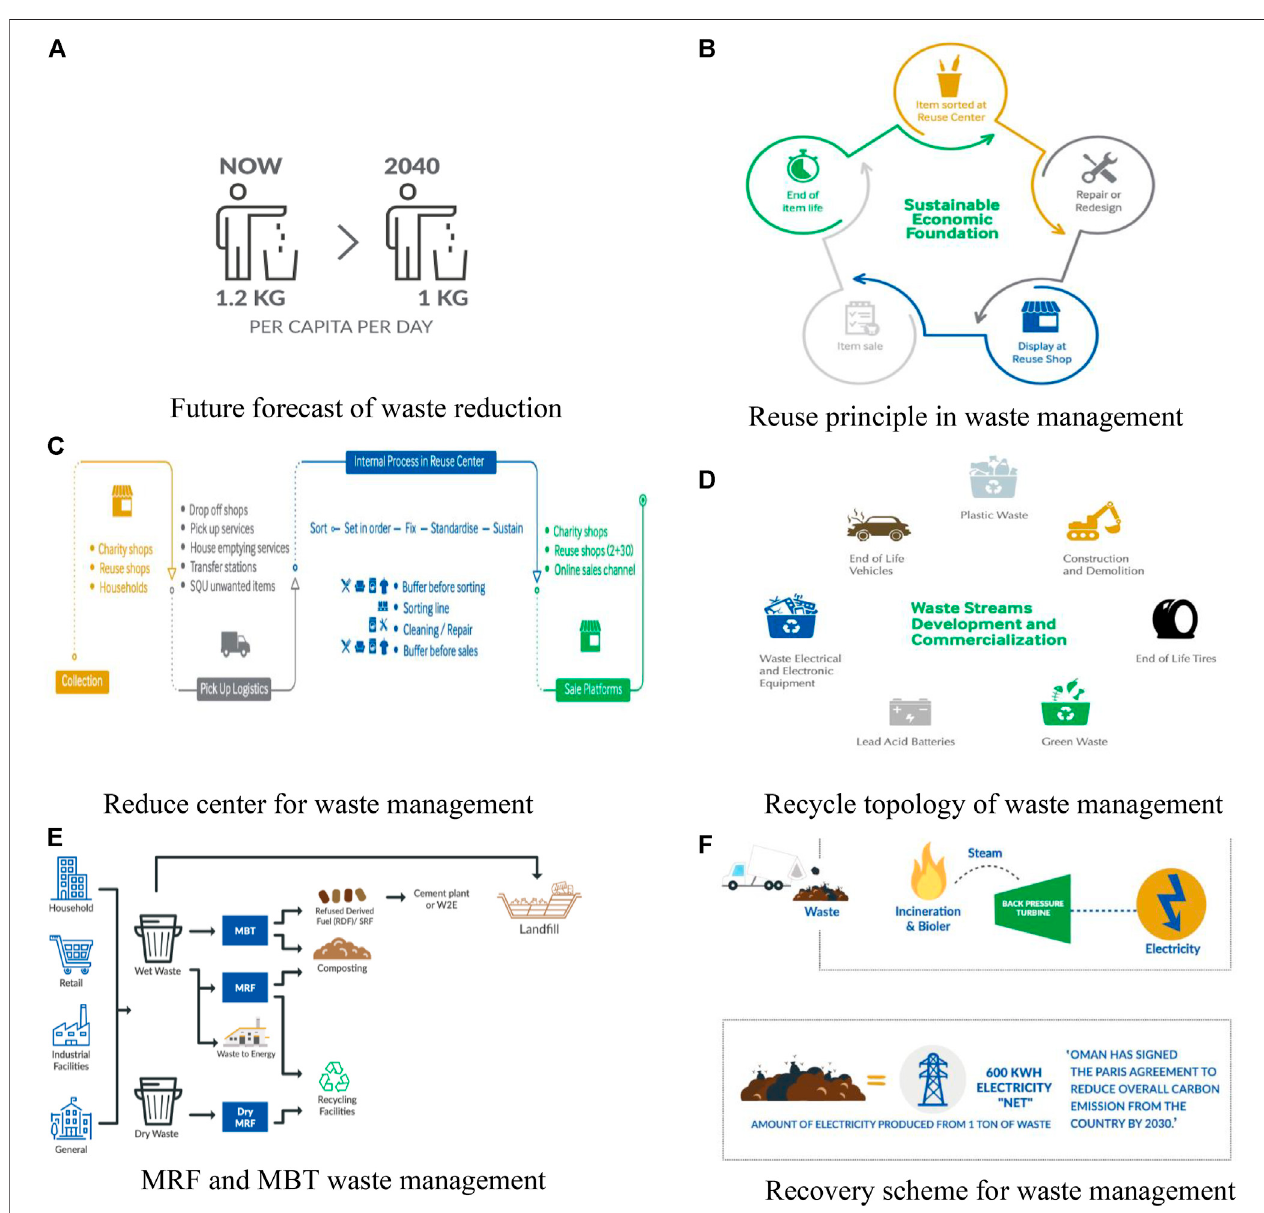
FIGURE7| ExistingwastemanagementschemesinOman. (A) Futureforecastofwastereduction, (B) reuseprincipleinwastemanagement, (C) reducecenterfor waste management, (D) recycle topology of waste management, (E) MRF and MBT waste management, and (F) recovery scheme for waste management.